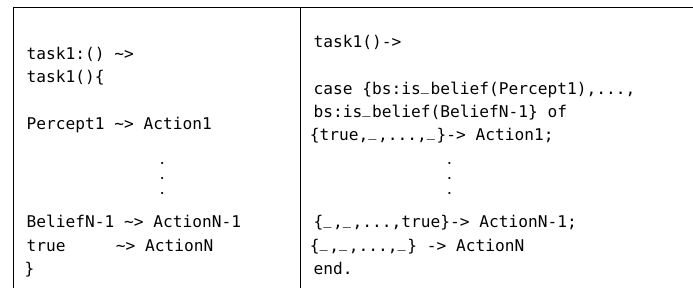
Table 4. From TeleoR percept/belief (left) to Erlang equivalent (right): general